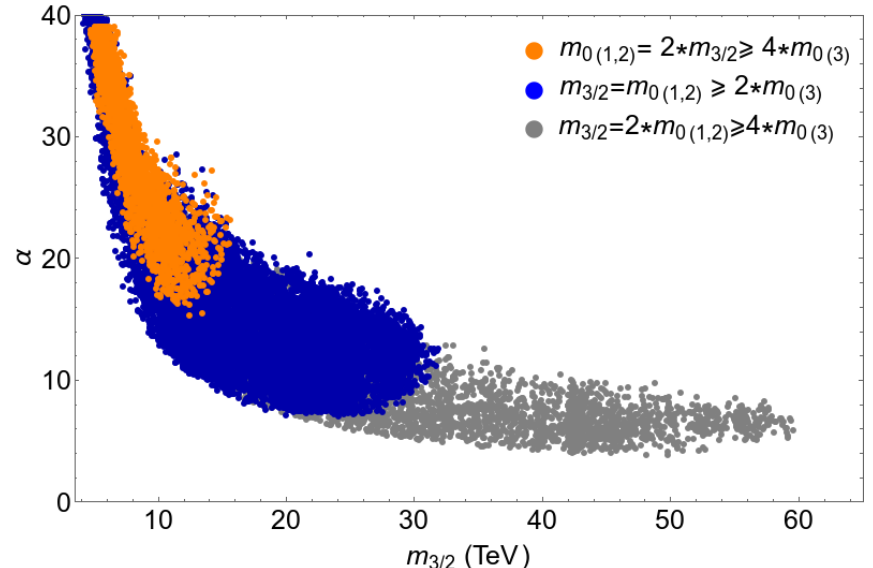
Figure 10 . Allowed SUSY solutions with (cid:1) EW < 30 in the (cid:11) vs. m plane from an extended 3 = 2 scan of the natural mini-landscape model with c m = 4 (cid:2) (16 (cid:25) 2 =(cid:11) ) 2 to enforce m 0 (1 ; 2) ’ 2 m 3 = 2 (orange points), c m = (16 (cid:25) 2 =(cid:11) ) 2 to enforce m 0 (1 ; 2) ’ m (blue points) and c m = 1 (16 (cid:25) 2 =(cid:11) ) 2 3 = 2 4 to enforce m 0 (1 ; 2) ’ 1 m (gray points) as described in section 4.2 of the text. To maintain the 3 = 2 2 hierarchy, we require m 0 (3) < min[ m 0 (1 ; 2) = 2 ; m = 2] in our scan. Other parameters scanned over 3 = 2 as in (cid:12)gure 6. We note there are gray points not visible under the orange and blue dots extending down to low values of m 3 = 2